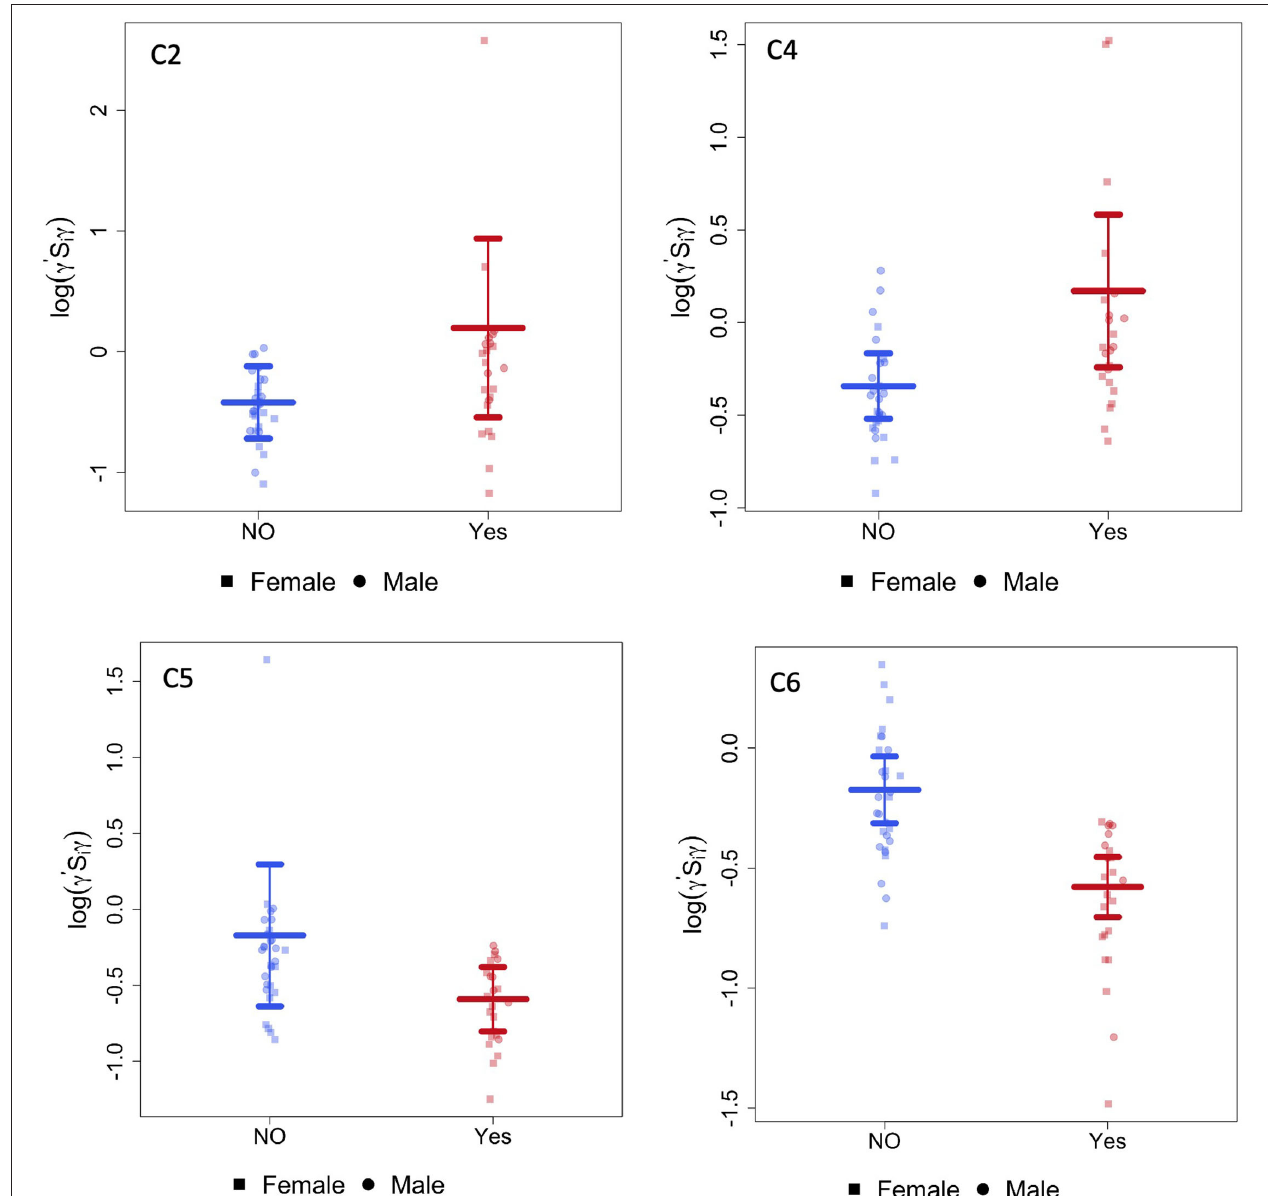
FIGURE 1 | CAP networks. Graphs of gestational age and sex adjusted intra-network connectivity in infants with POE (labeled “yes”) and control infants (labeled “NO”) for the CAP networks (C2,C4, C5, and C6) that were significantly different between the two groups after correcting for multiple network comparisons as well as for gestational age and sex.